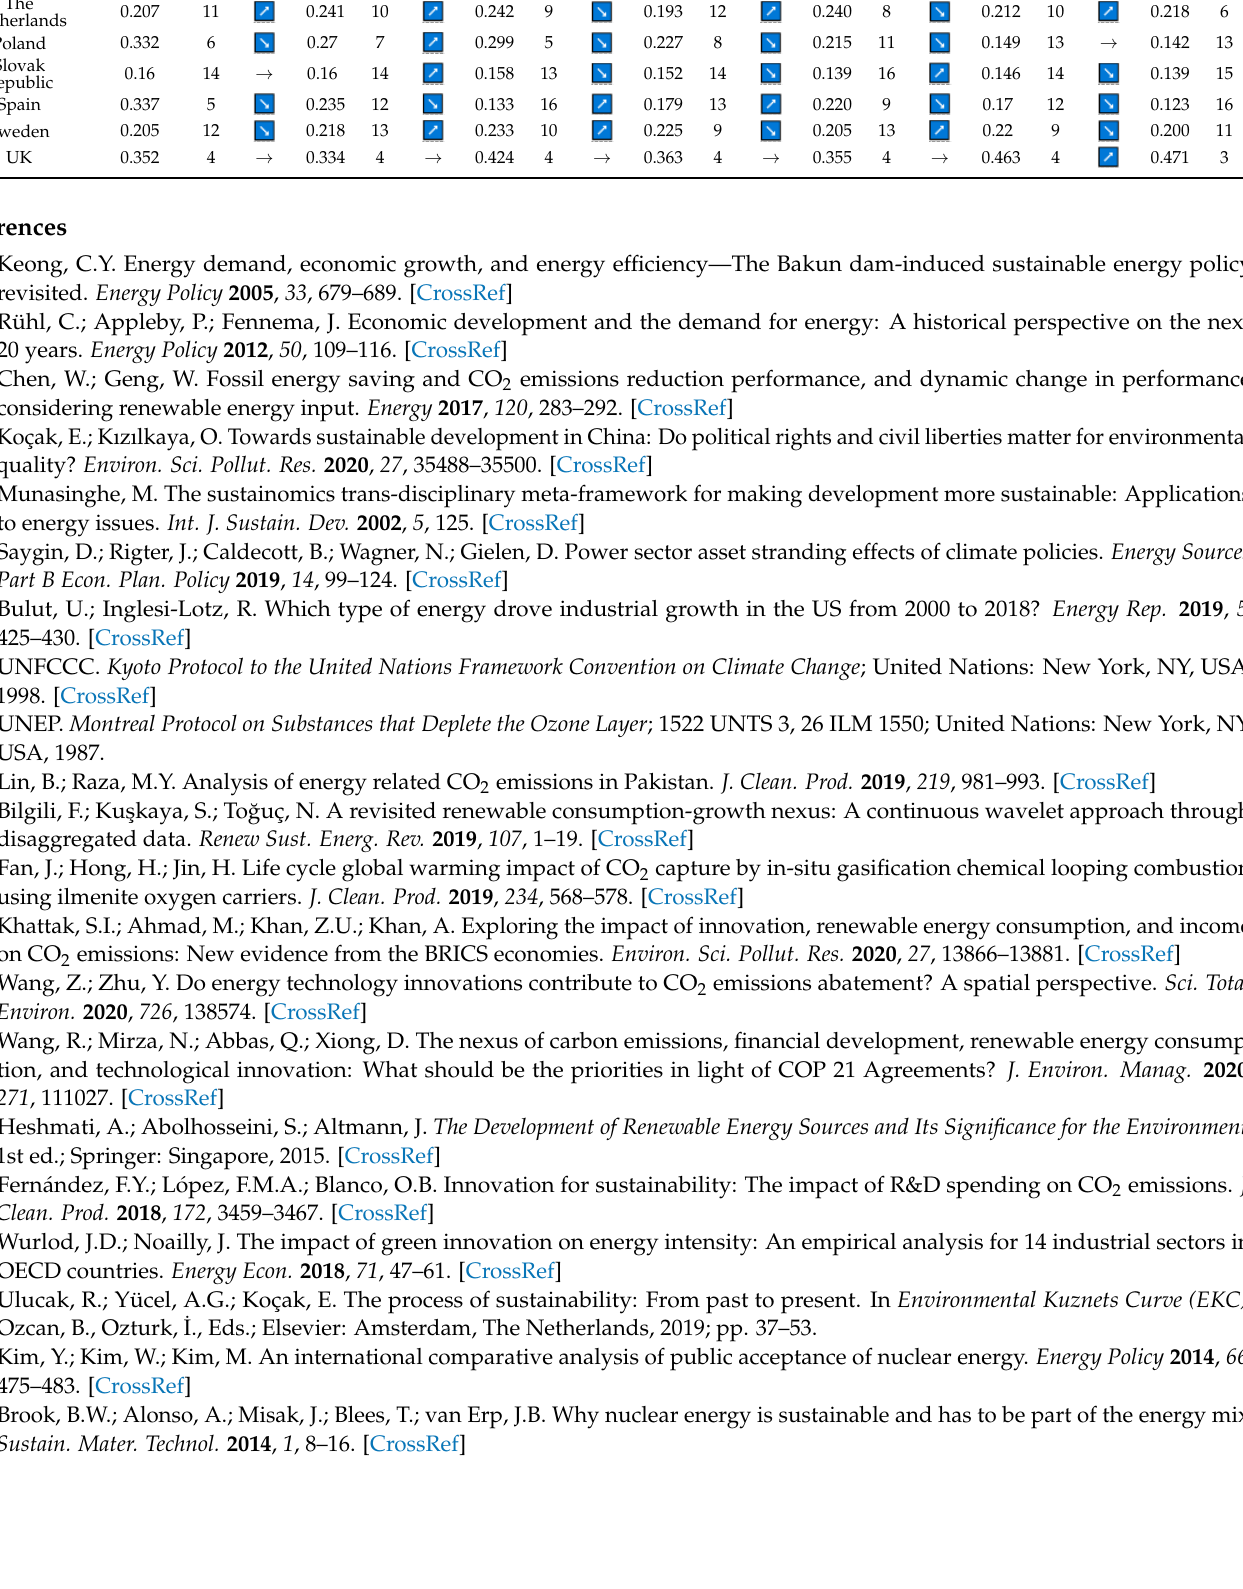
Table A2. Result of a multivariate analysis of the environmental effectiveness of R&D spending in the energy sector from 2011 until 2017/2019.